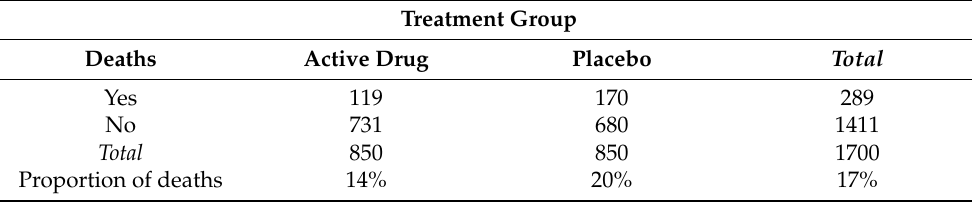
Table 2. Results of the multi-center, randomized, double-blind, placebo-controlled trial. Treatment